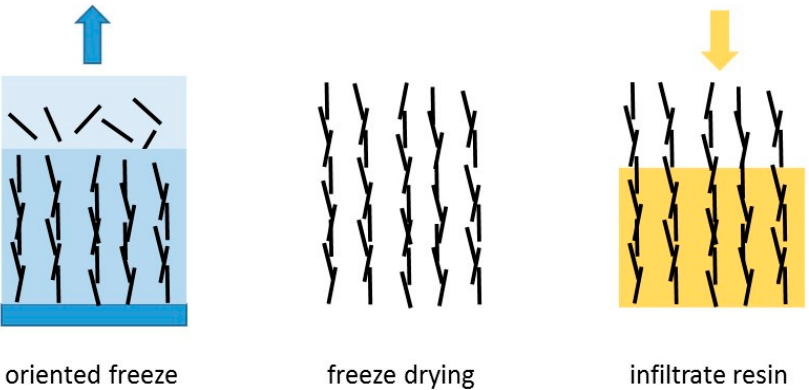
Figure 11. Schematic illustration of aerogel procedure for fabricating 3-dimensional oriented epoxy- BN nanosheets (BNNS) composites.